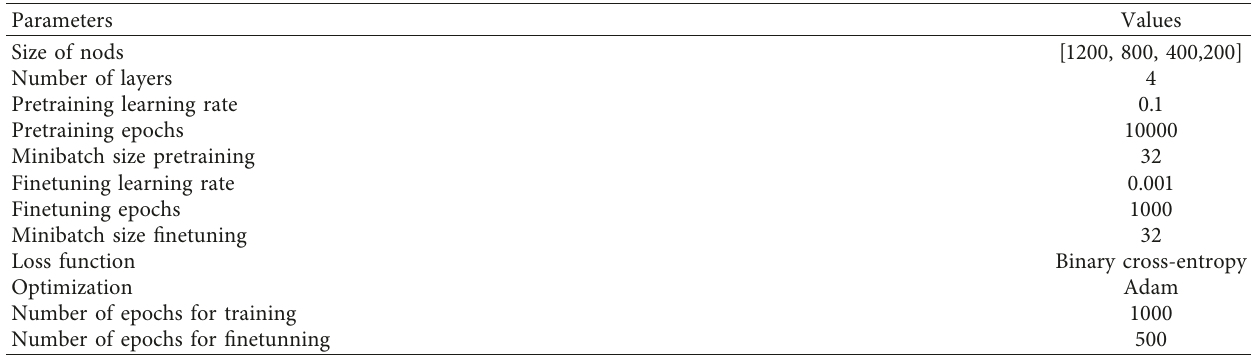
Table 2: Parameters of DAE for brain